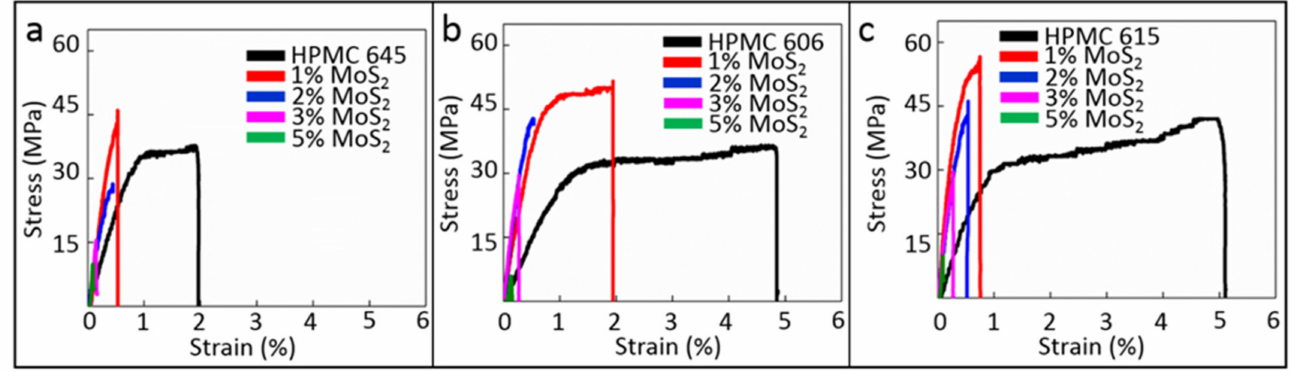
Figure 2. Nano-tensile tester results of the ( a ) MoS 2 /HPMC 645, ( b ) MoS 2 /HPMC 606, and ( c ) MoS 2 /HPMC 615